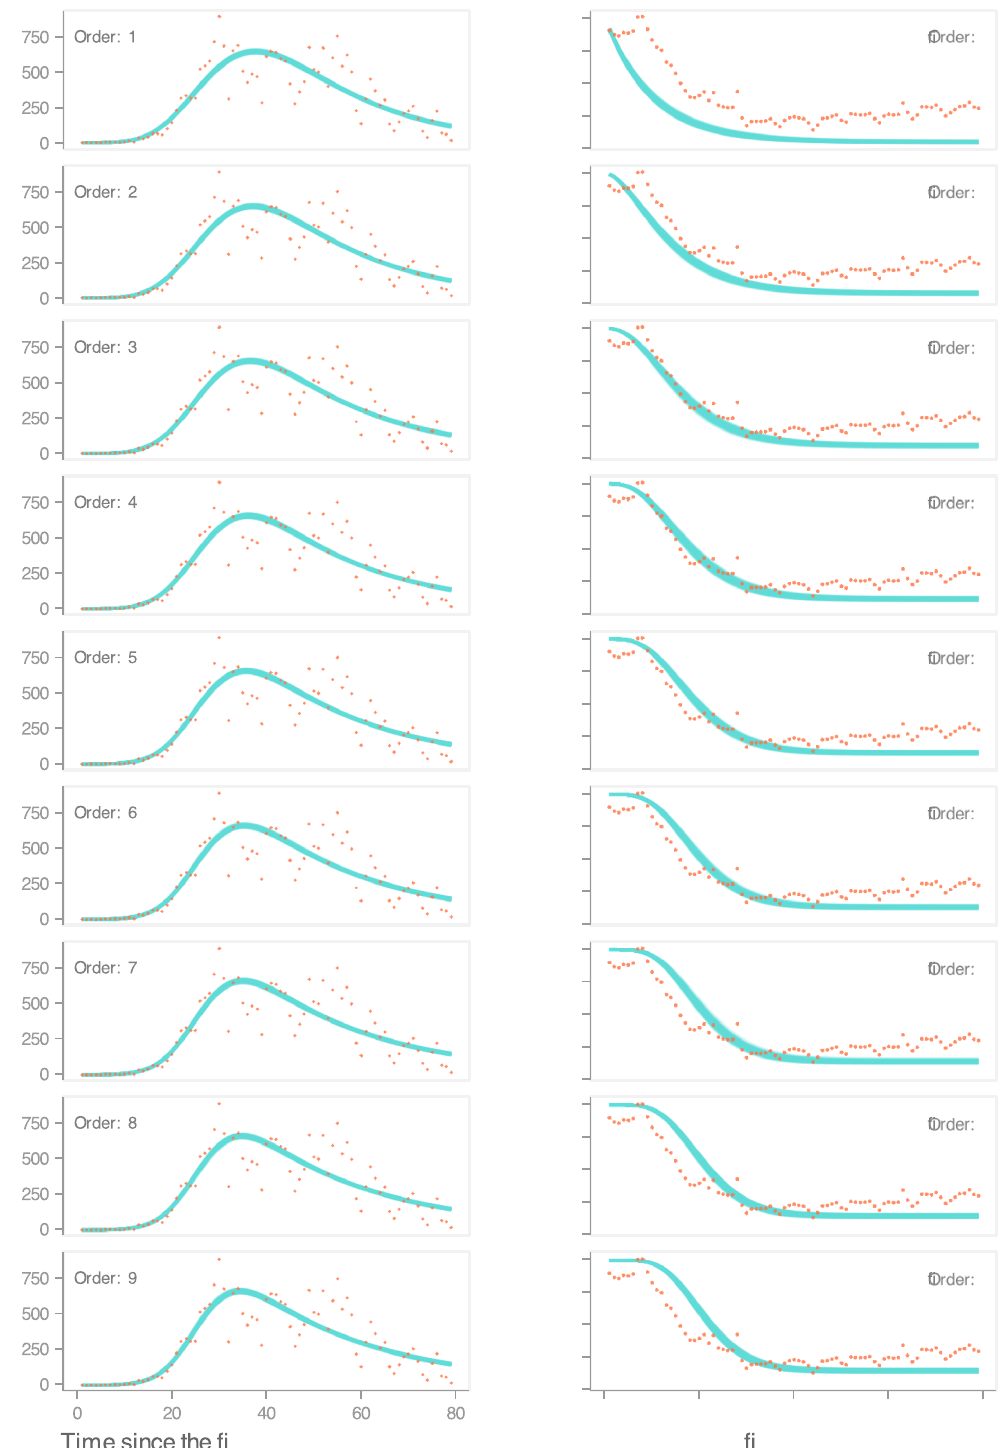
Fig 6. Inference on DGP3. Comparison between expected values and data. On the LHS, for each model, we show 100 overlapped simulations of the predicted incidence against daily case counts. On the RHS, for each model, we show 100 overlapped simulations of the predicted relative transmission rate against Apple’s mobility data. In this plot, we estimate the predicted values from the posterior distribution of each of the DGP3’s nine candidate process models.